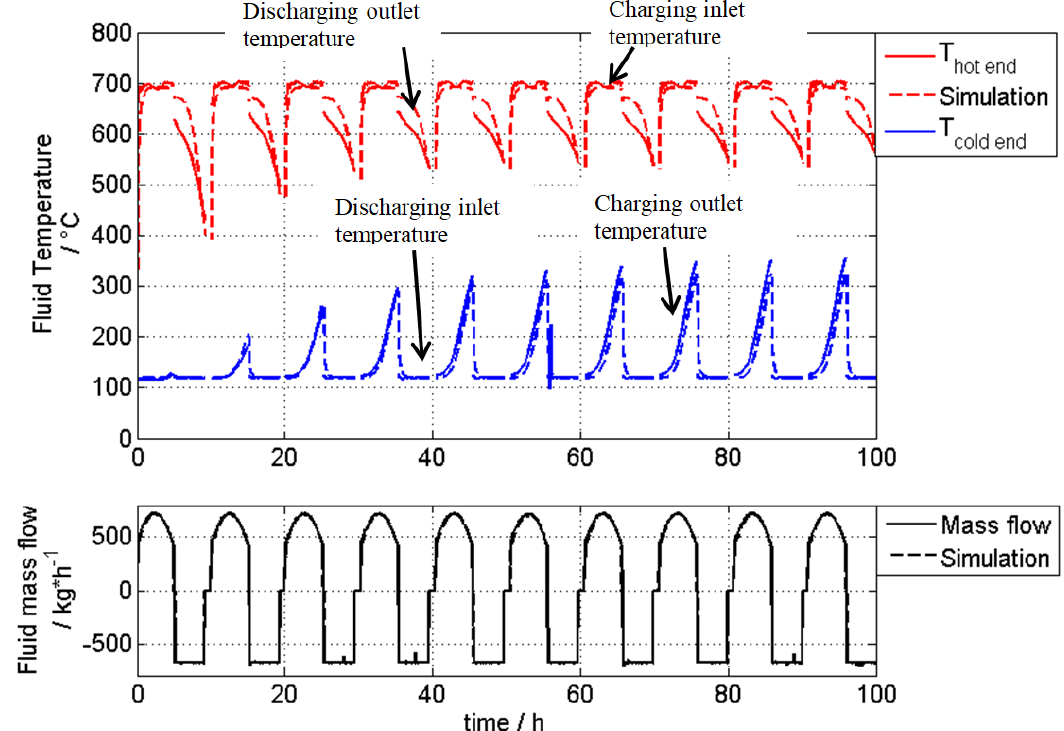
Figure 8. 21 March: Fluid temperature at TES cold end (blue) and hot end (red), mass flow while charging and discharging (black); solid lines represent the experimental results and dashed lines show the simulation model results.